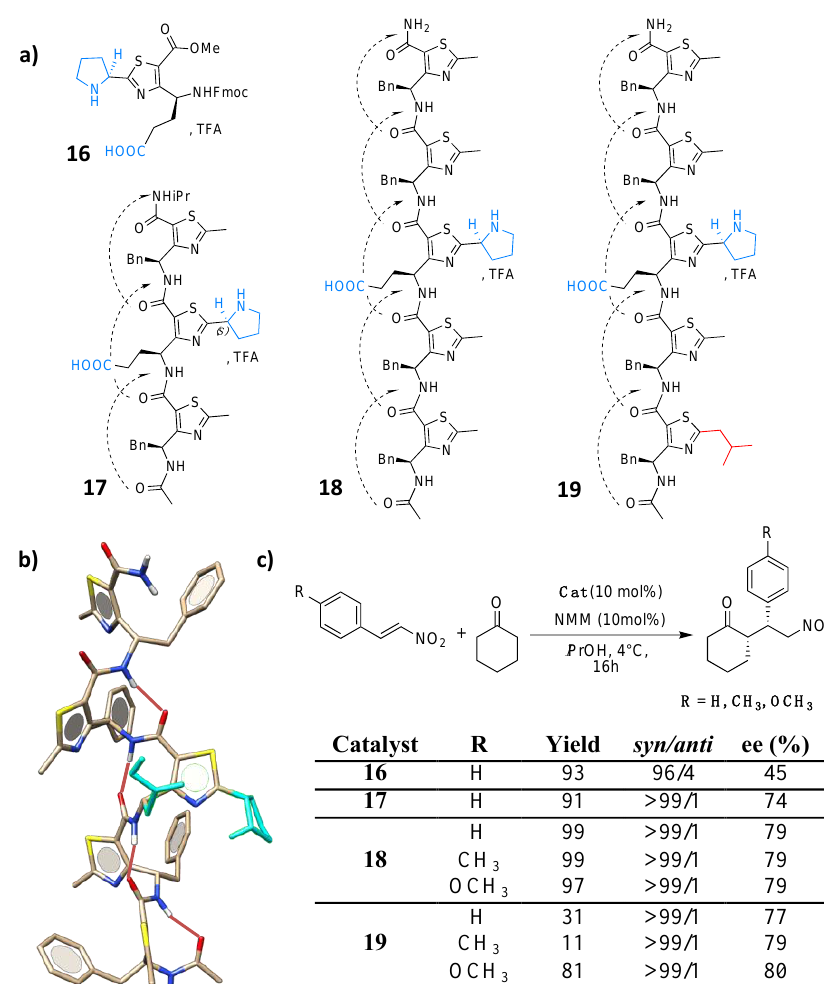
Figure 4. ( a ) ATC (4-amino(methyl)-1,3-thiazole-5-carboxylic acids)-based catalysts. ( b ) Lowest energy NMR solution structures of 18 in i PrOH. Catalytic groups are in light blue. ( c ) Nitro-Michael addition reaction of cyclohexanone to β -trans-nitrostyrene (R = H), trans-4-methyl- (R = CH 3 ) and trans-4-methoxy- β -nitrostyrene (R = OCH 3 ) using ATC-based catalysts.